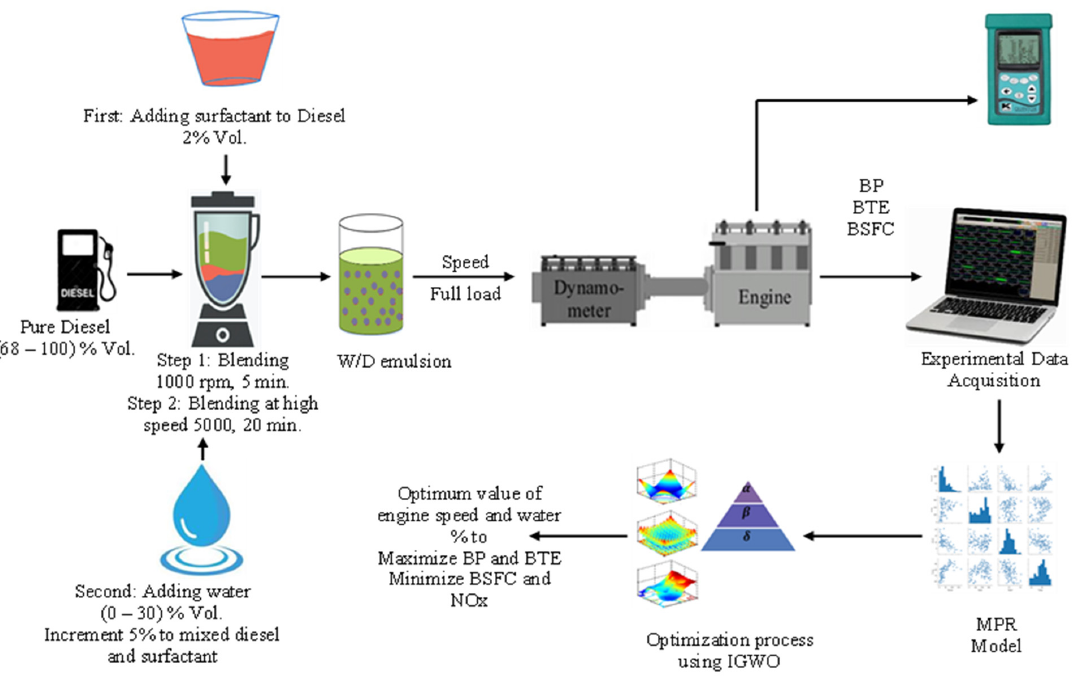
Figure 4. A schematic portrayal of the experimental strategy combined with an optimization method.